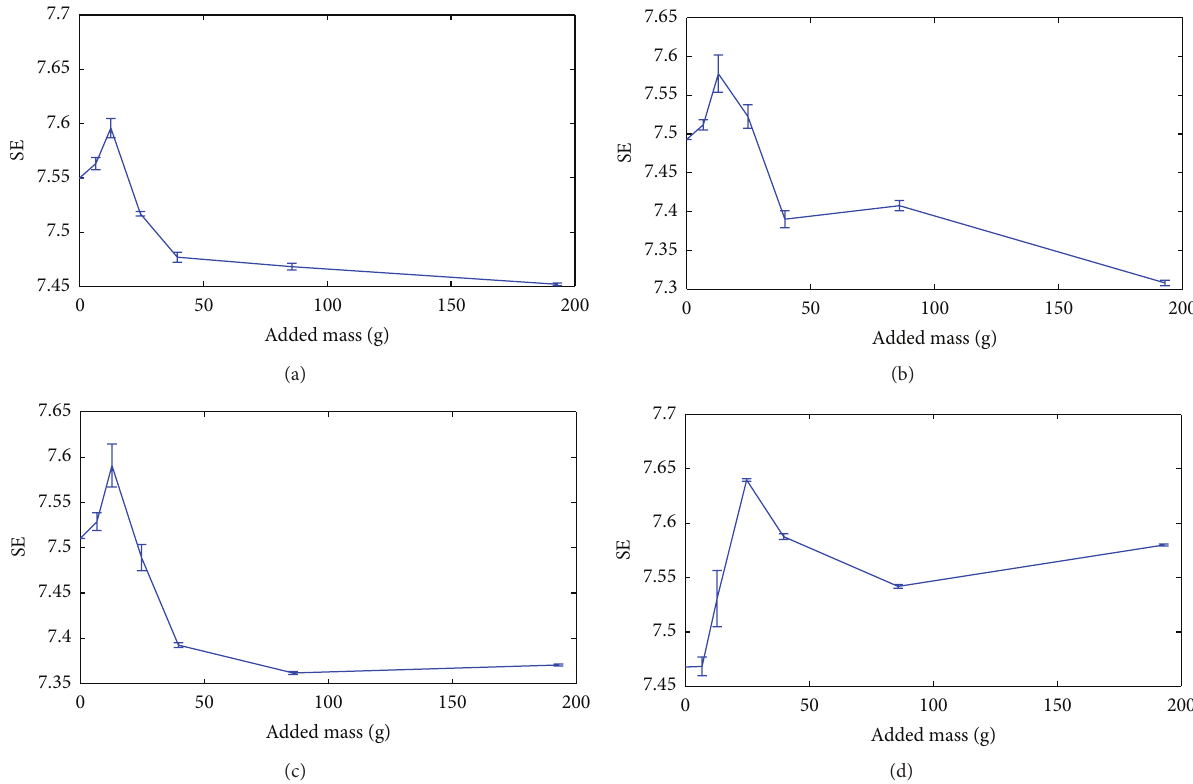
Figure 7: Variation of SE with the added mass in position 2 for (a) Sensor S1; (b) Sensor S2; (c) Sensor S3; (d) Sensor